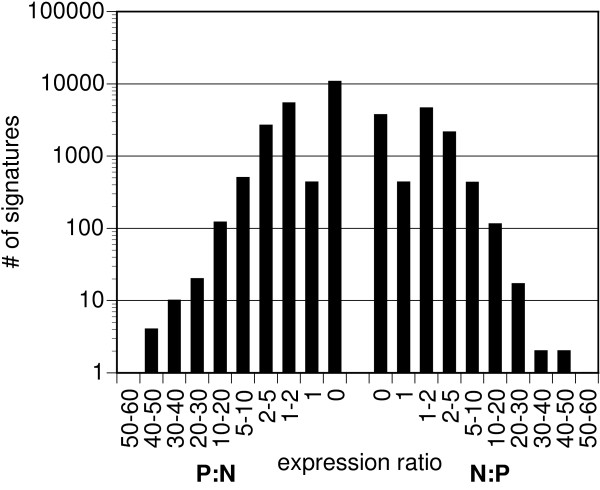
Comparison of expression for all of the A. fundyense signatures. The expression ratios compare the abundance of each signature between the two libraries. Bars indicate the number of signatures with an expression ratio within the stated range. Expression ratios were calculated to be ≥1, so that signatures that are more highly expressed in the P/40 library are to the left (P:N) whereas those with greater expression in the N/40 library are to the right (N:P). The exceptions are signatures with ratio = 1, these are repeated on the two sides of the figure, and those with ratio = 0.